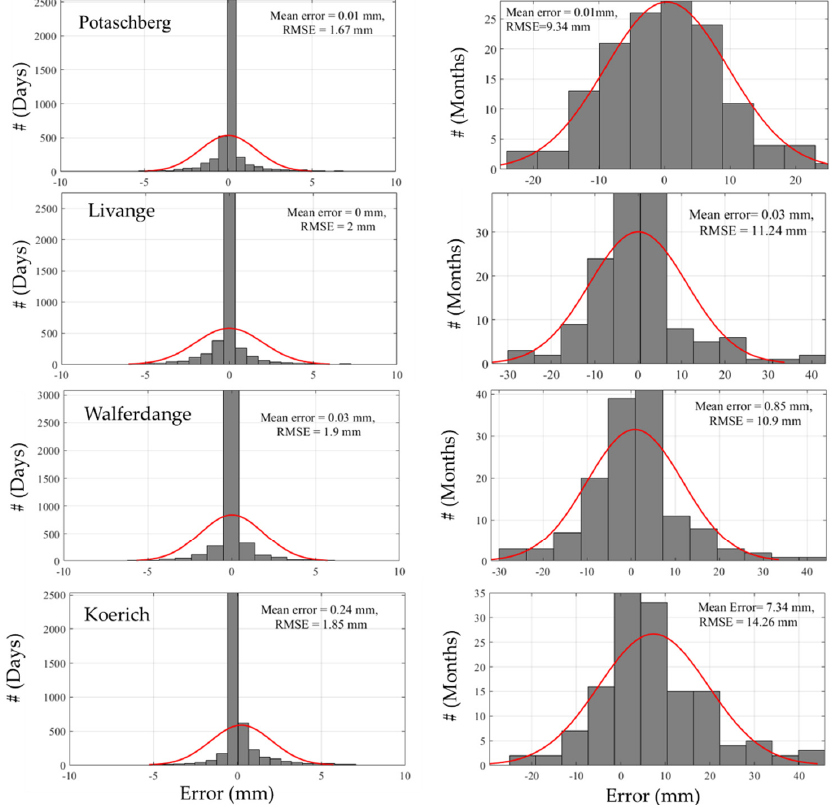
Figure 9. Normaldistributionoferrorsinvalidationstations; ( Left )panel: dailyrainfalldata; ( Right )panel: Figure 9. Normal distribution of errors in validation stations; Left panel: daily rainfall data; Right Monthly rainfall panel: Monthly rainfall data.